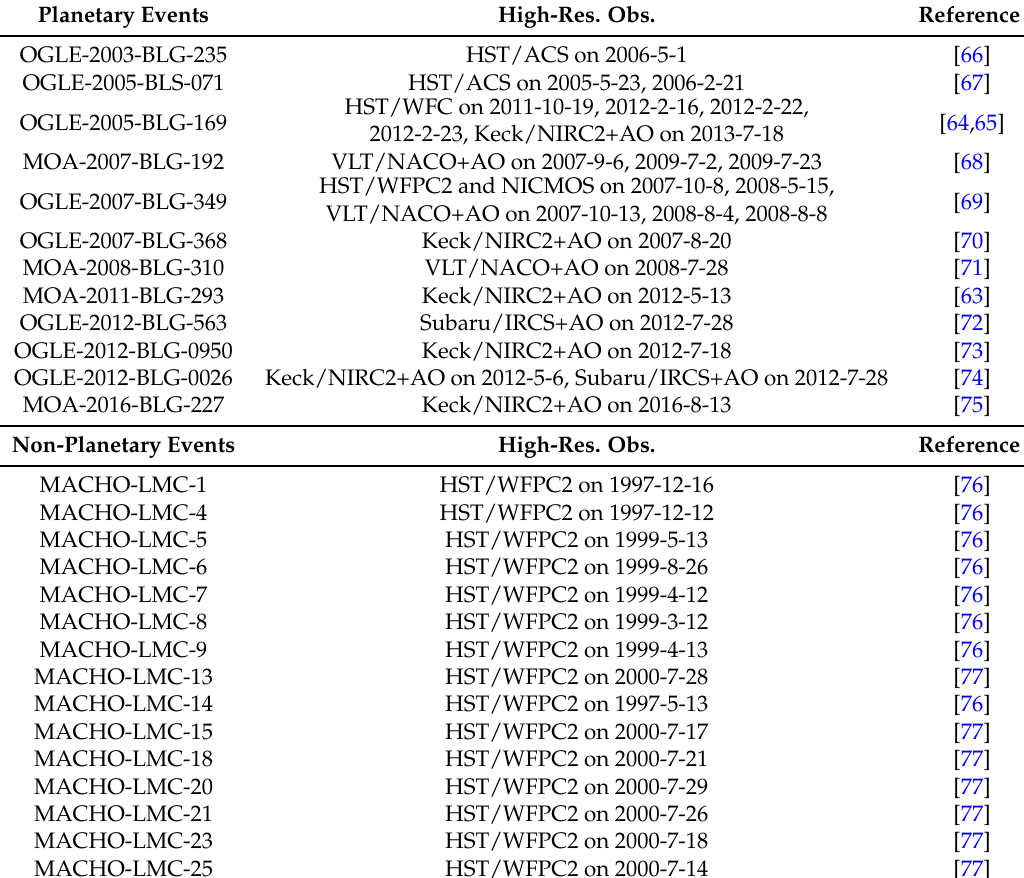
Table 1. High resolution observations of microlensing